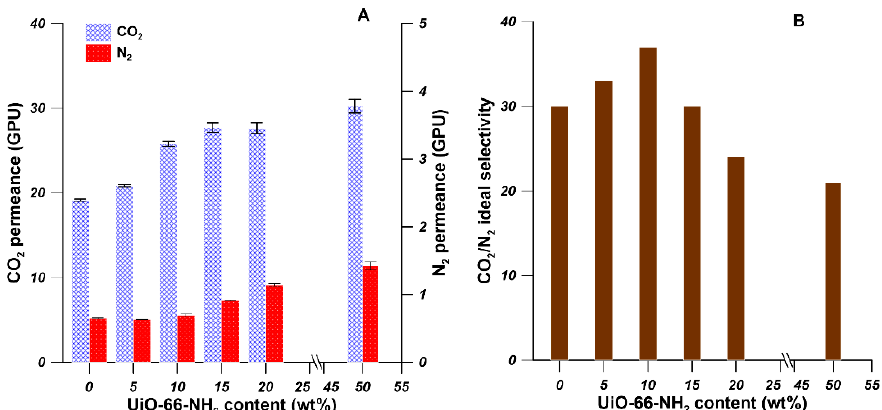
Figure 9. The effect of UiO-66-NH 2 content on the CO 2 and N 2 permeances ( A ) and CO 2 /N 2 ideal selectivity ( B ) of Pebax ® 2533-UiO-66-NH 2 /PP thin film mixed matrix hollow fiber membranes.